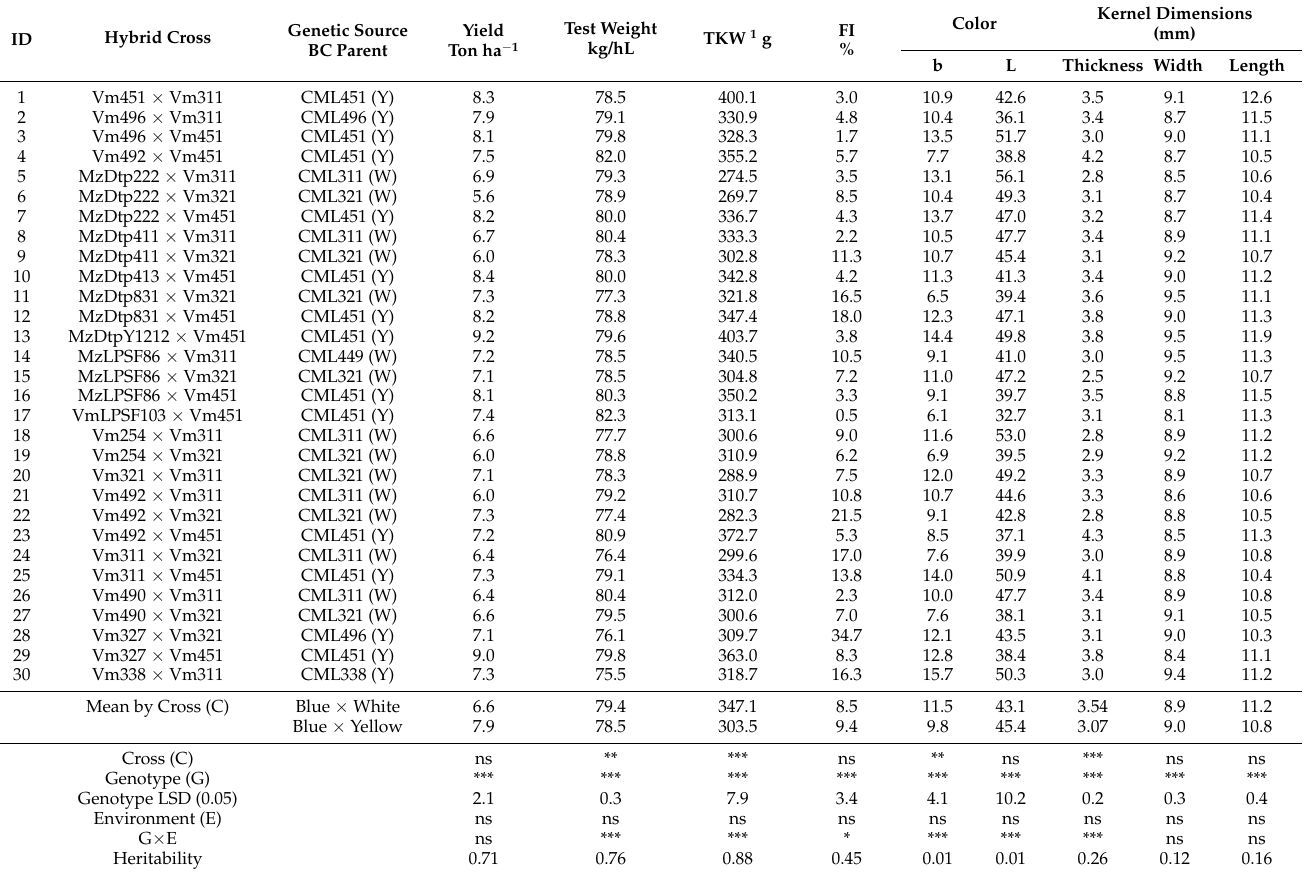
Table 1. Combined analysis of the yield and kernel properties of 30 Vitamaiz hybrids grown in two subtropical environments (CEL—Celaya; PV—Puerto Vallarta, Mexico) in